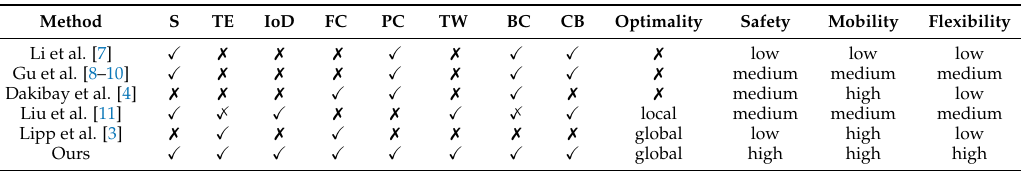
Table 2. Capacity of different speed planning